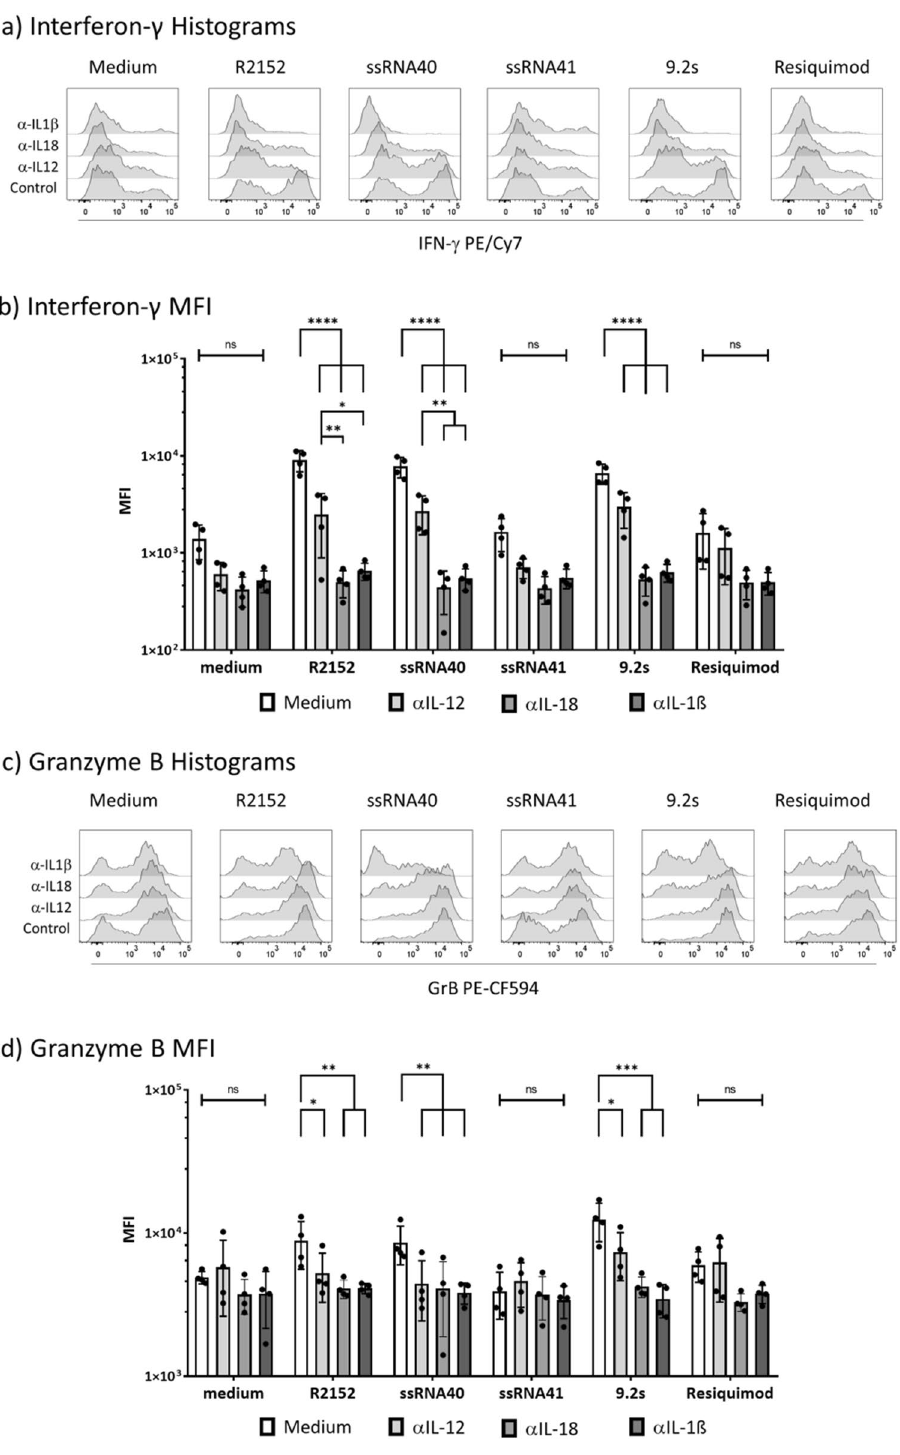
Figure 4. Modulation of cytokine induction in Vδ2 T cells by anti-cytokine antibodies. PBMC were activated with HMBPP in the presence or absence of TLR8 ligands and additional presence or absence of 5 µg/mL of neutralizing anti-cytokine antibodies as indicated. Intracellular expression of IFN-γ ( a , b ) and GrB (c,d) in CD3 + Vδ2 + γδ T cells was analyzed after 24 h. The lower histograms in each panel of ( a ) and ( c ) show the upregulated cytokine expression in the absence of anti-cytokine antibodies (“controls”). ( a ), ( c ) representative histograms; ( b ), ( d ) Summary of four experiments. Results are expressed as mean fluorescence intensity on a logarithmic scale (MFI) ± SD. Statistical significance is indicated with * p < 0.05, ** p < 0.01, *** p < 0.001, **** p < 0.0001. ns, not